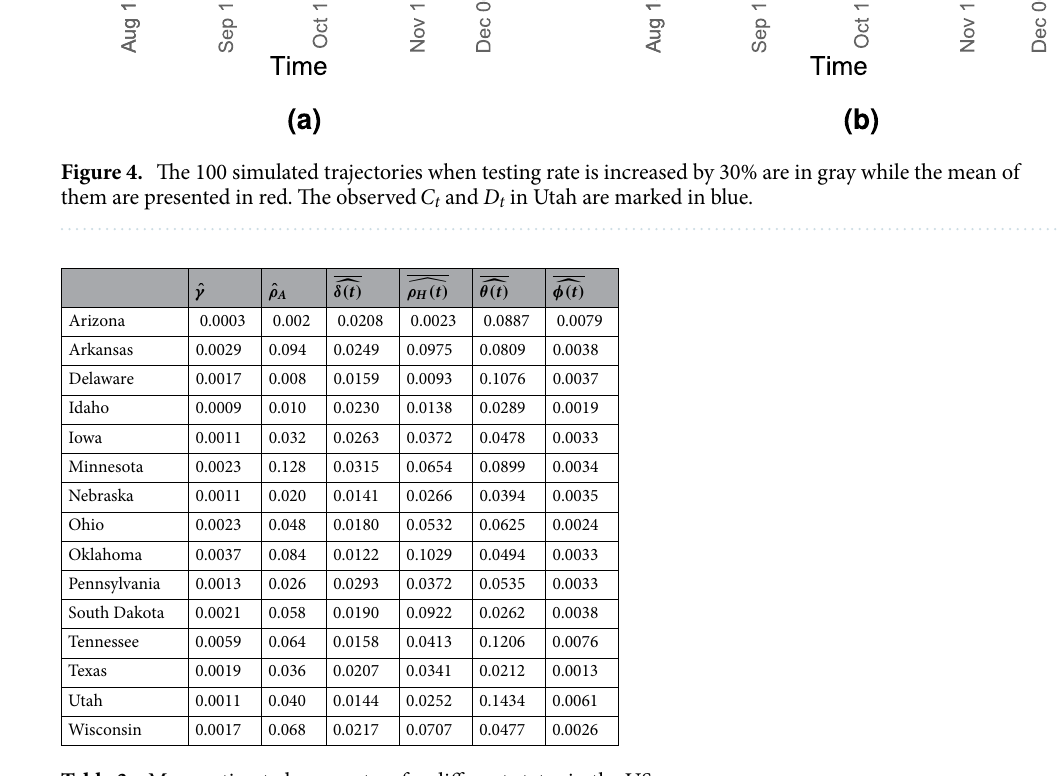
Table 3. Mean estimated parameters for different states in the